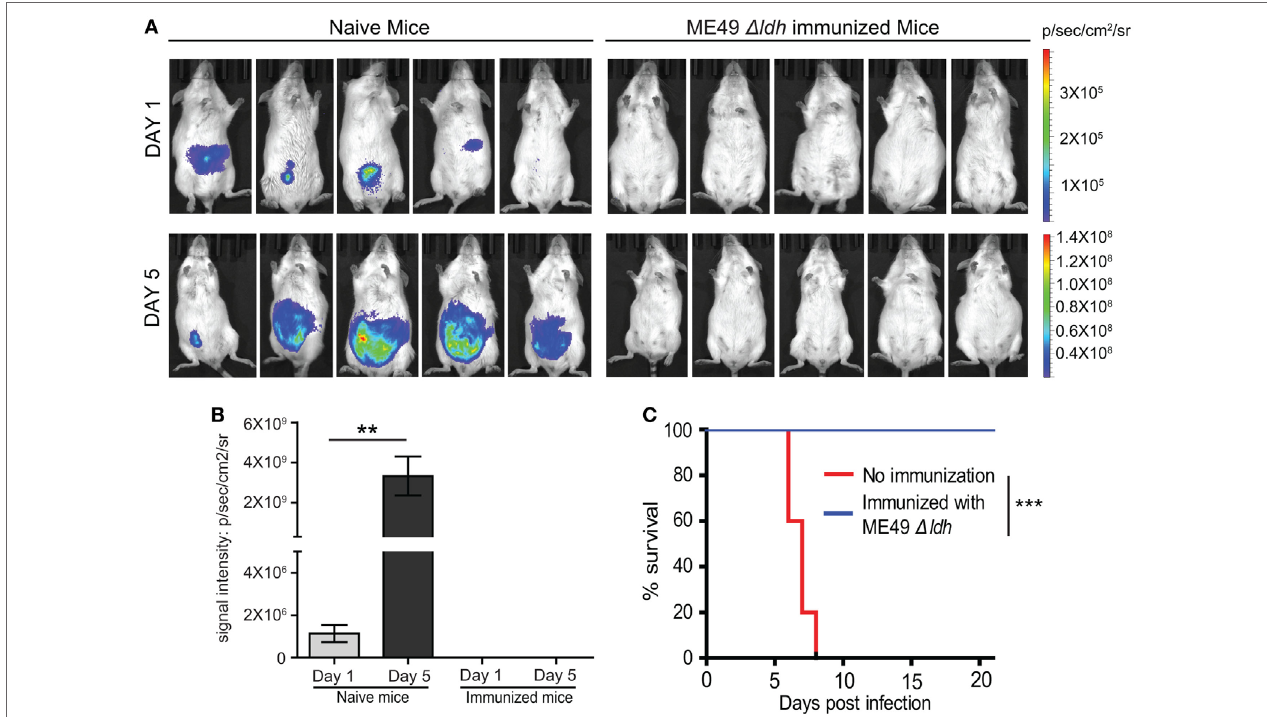
FigUre 5 | Δ ldh parasite vaccination elicited rapid clearance of challenging parasites. (a) Naïve or pre-immunized mice were challenged with 10 4 tachyzoites of RH-Luc (five mice for each group). Parasite loads in mice 1 and 5 days post RH-Luc infection were analyzed by live animal imaging on the IVIS Spectra system. p/sec/cm 2 /sr: photons per second per cm 2 per steradian. (B) Total bioluminescent signals of mice from (a) were calculated and graphed, ** p < 0.01, Student’s t -test. (c) Survival curves of naïve or Δ ldh immunized mice infected with RH-Luc, *** p < 0.001, Gehan–Breslow–Wilcoxon